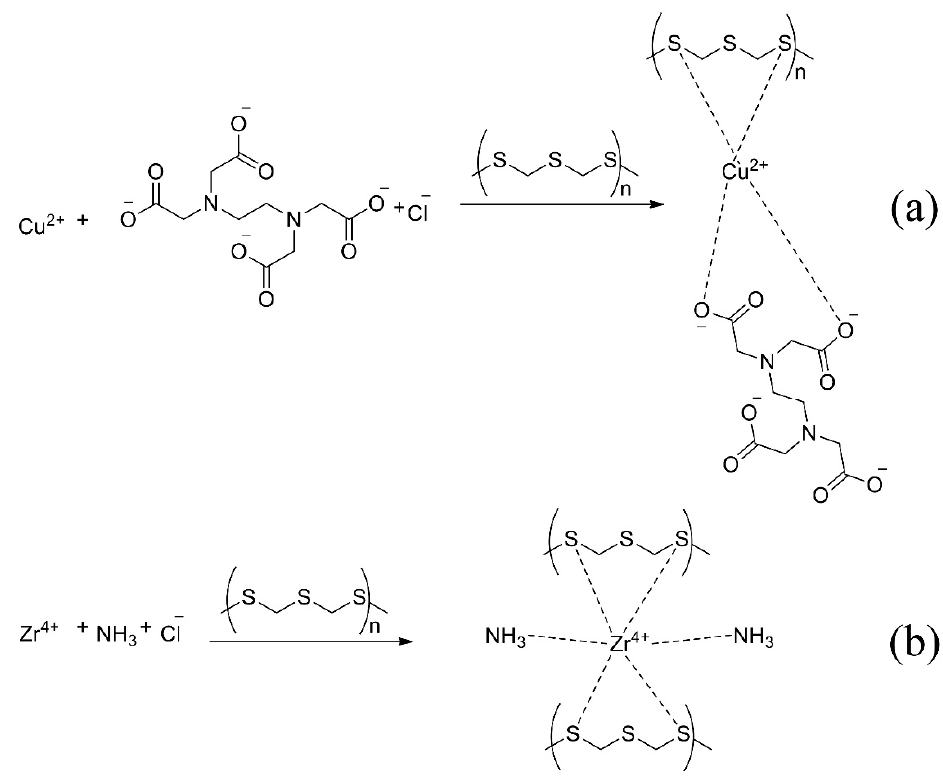
Figure 6. The proposed mechanism of sorption with EDTA ( a ) and ammonia ( b ).